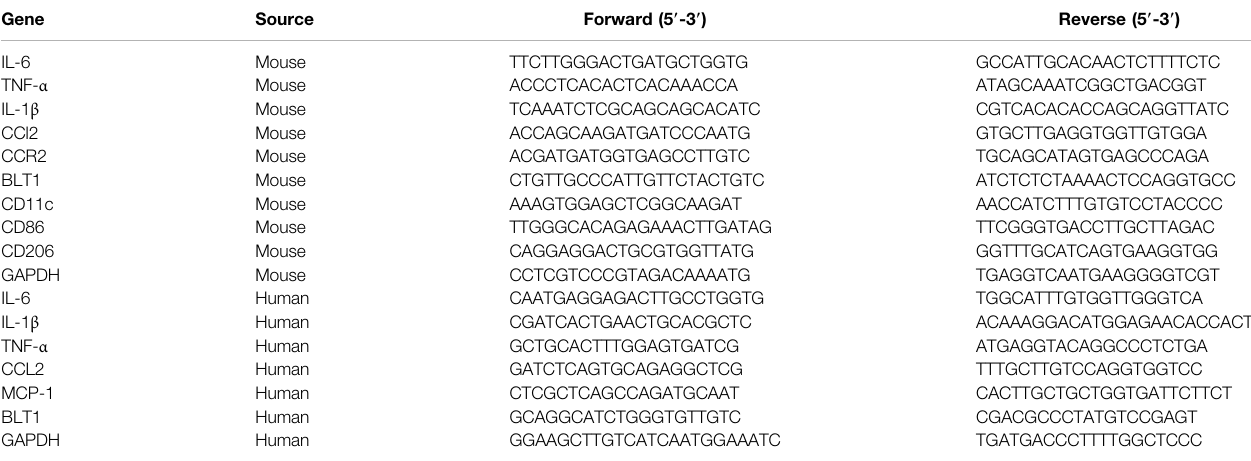
TABLE 1 | Primers for RT-PCR